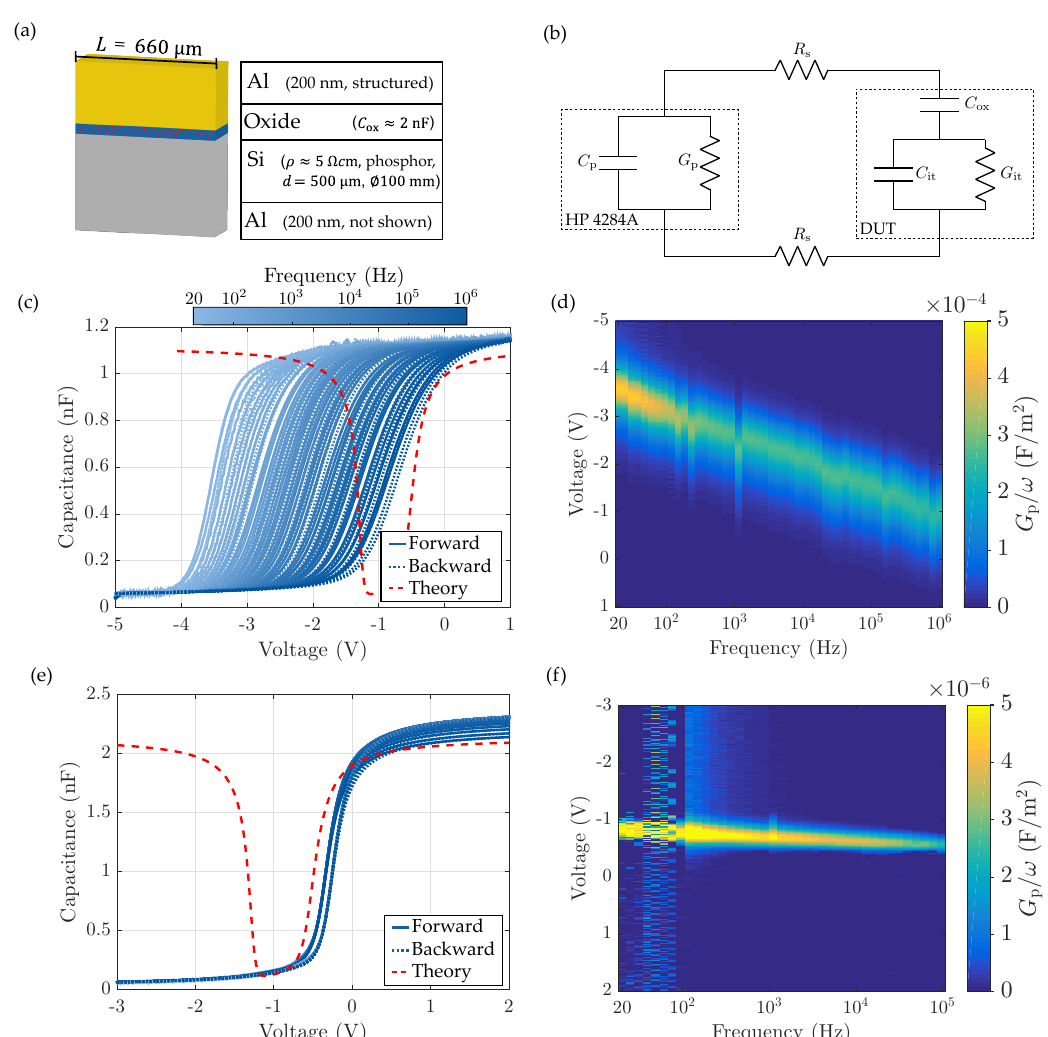
Figure 4. Electrical characterization of the Si/SiO 2 layer stack with respect to defect densities and post-metal annealing. ( a ) Schematic of a metal-oxide-semiconductor capacitor with a structured top metal electrode with an area L 2 . ( b ) Equivalent circuit of the measurement setup tuned in depletion. The device under test (DUT) is modeled by an oxide capacitance C ox and a parallel capacitance C it and conductance G it . Additional contact resistances are modeled by R s . The parallel capacitance C p and conductance G p are measured. ( c ) Measurement of Al/SiO 2 /Si capacitor. SiO 2 is deposited by CVD on a <111>-oriented substrate with a measured thickness of ( 17.0 0.1 ) nm and an aluminum top ± electrode with an area of 0.52mm 2 . Darker curves indicate higher frequencies and lighter curves lower frequencies. The dashed curves indicate voltage backward sweeps. The red dashed line corresponds to the calculated theoretical quasi-static CV-curve. ( d ) Measurement of the parallel conductance over angular frequency G p / ω corresponding to (c). ( e ) Measurement of annealed Al/SiO 2 /Si capacitor. SiO 2 is deposited by CVD on a <111>-oriented substrate with a measured thickness of ( 16.0 0.1 ) nm ± and an aluminum top electrode with an area of 1.05mm 2 . Post-metal annealing is carried out in N 2 H 2 at 400 ◦ C for 30min. ( f ) Measurement of the parallel conductance over angular frequency G p / ω corresponding to (e). For frequencies f 100Hz, ground oscillations are ≤